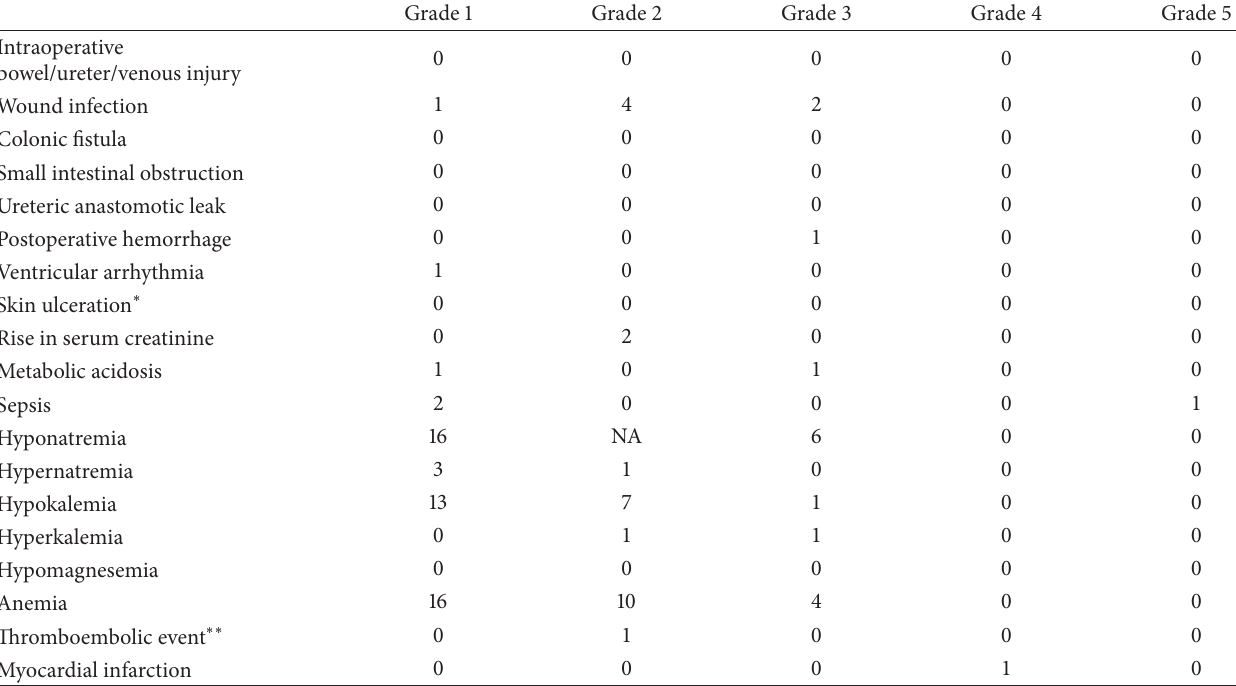
Table 3: Acute toxicity within 30 days of surgery.